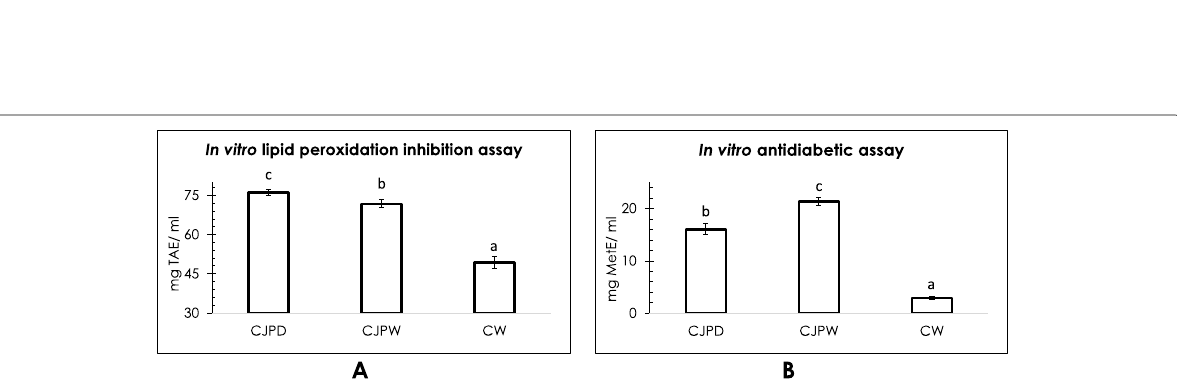
Fig. 5 Results of in vitro lipid peroxidation inhibition assay ( A ) and in vitro antidiabetic activity ( B ). Values are means with different superscripts in each figure are significantly different ( P < 0.05). TAE: tocopheryl acetate equivalent; MetE: metronidazole